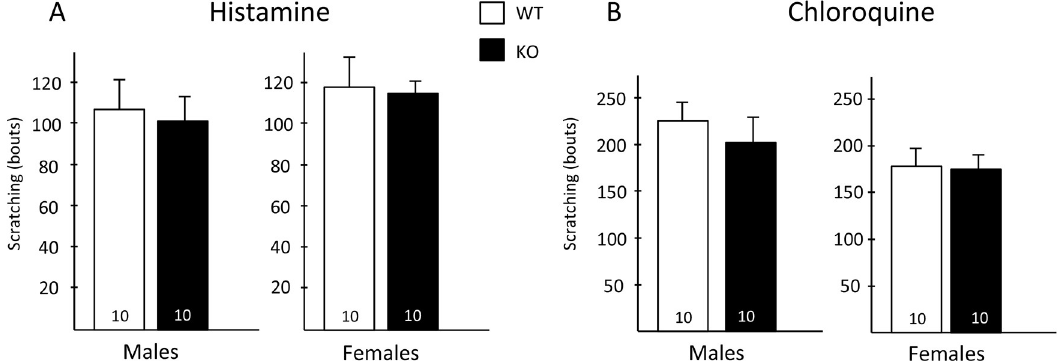
Fig 5. Pruritogen responsiveness in Hippocalcin-like 4 mice. Male and female Hpcal4 mutant mice respond normally (scratching bouts) to nape of the neck injection of histamine (A) or chloroquine (B). Data are presented as mean ± SEM. Statistical significance was determined by Student’s